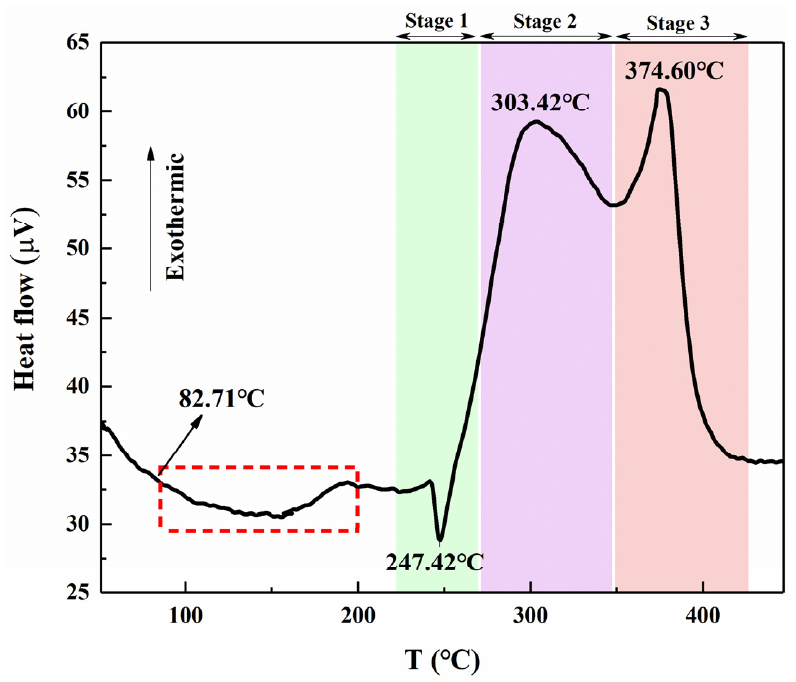
Figure 12. DTA curve of the 3D-printed grain.